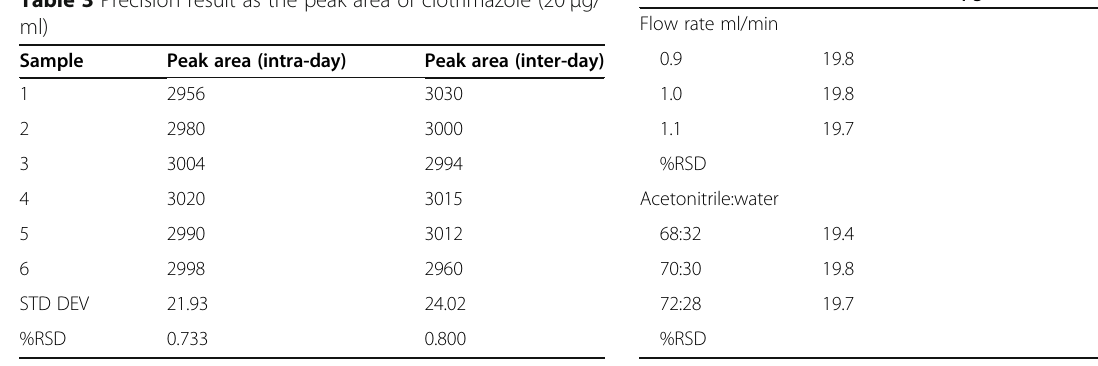
Table 3 Precision result as the peak area of clotrimazole (20 μ g/